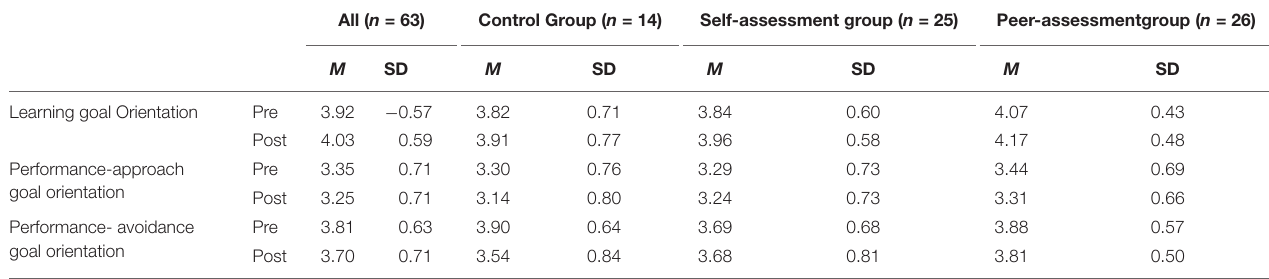
TABLE 2 | The fundamental